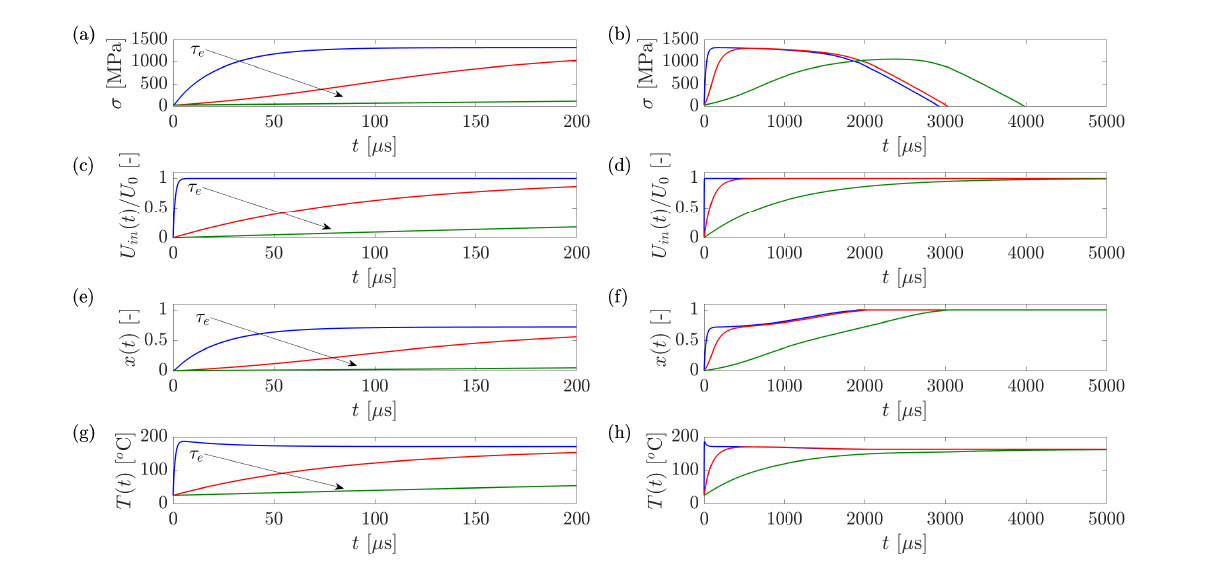
[ 10 − 6 ,10 − 4 ,10 − 3 ] s. ∈